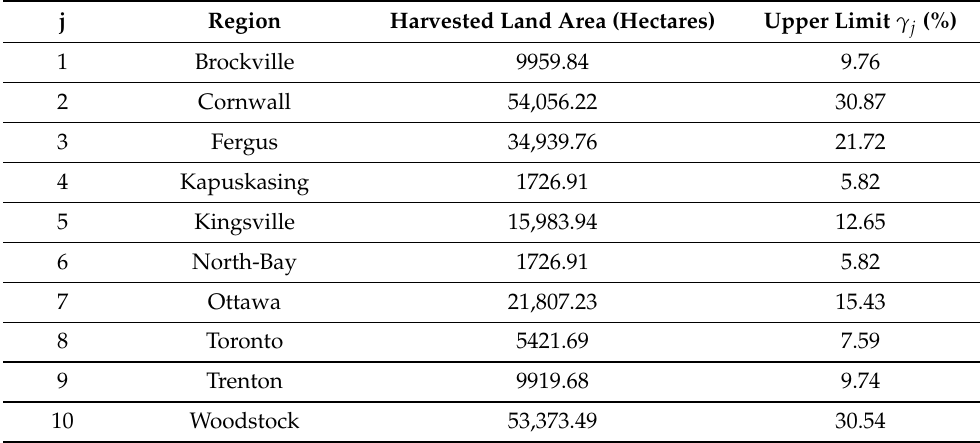
Table A1. Land area used for corn